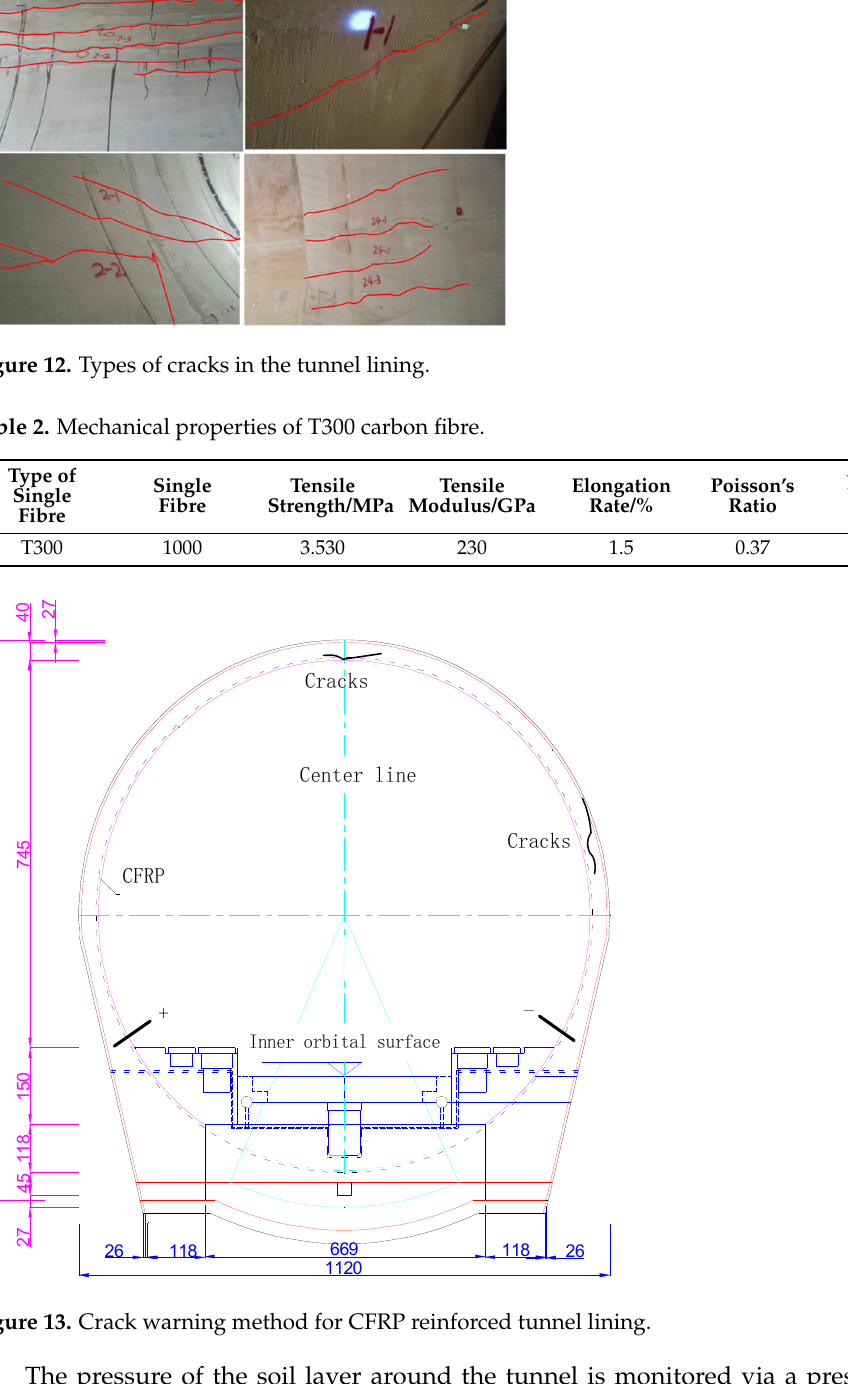
Figure 14. Monitoring values for confining pressures in deeply buried tunnel.